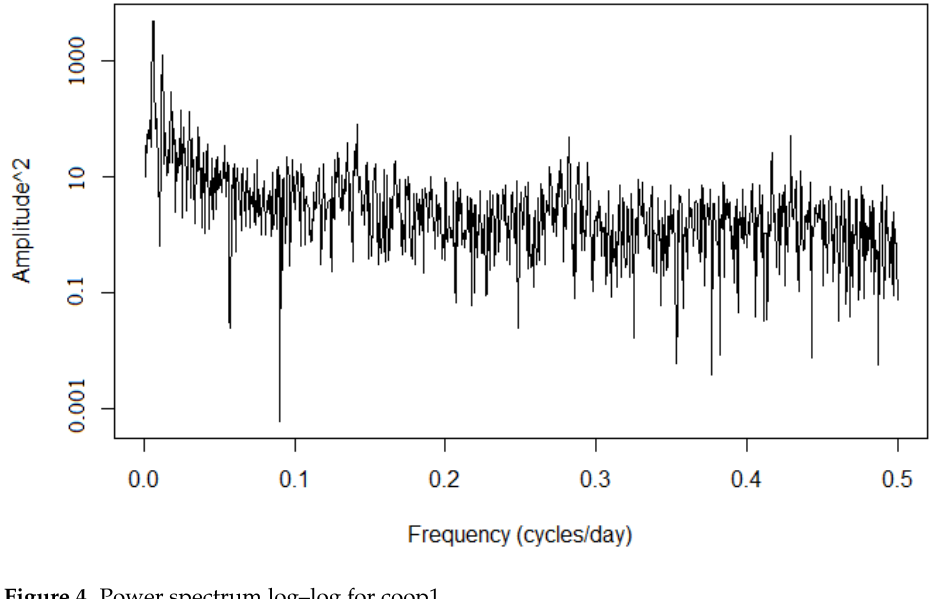
Figure 4. Power spectrum log–log for coop1.